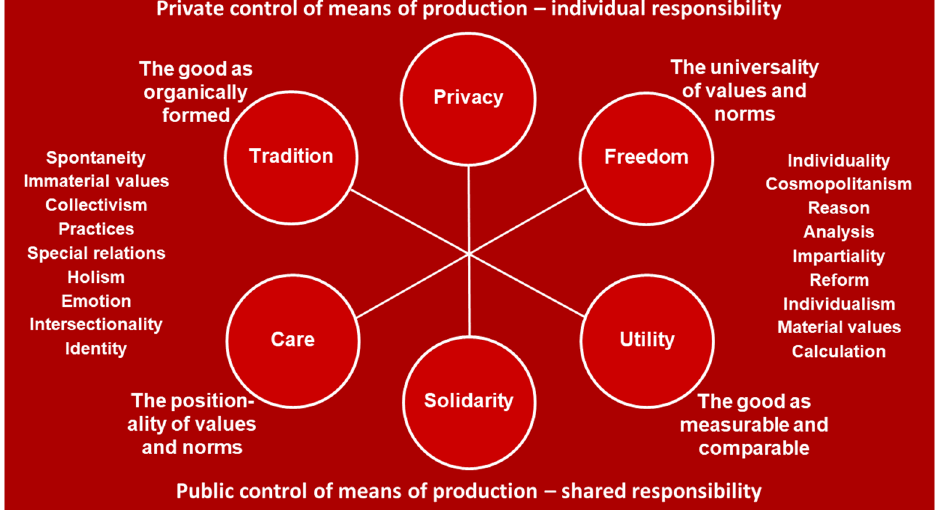
Figure 1. Political moralities on a map of justice with their background assumptions.